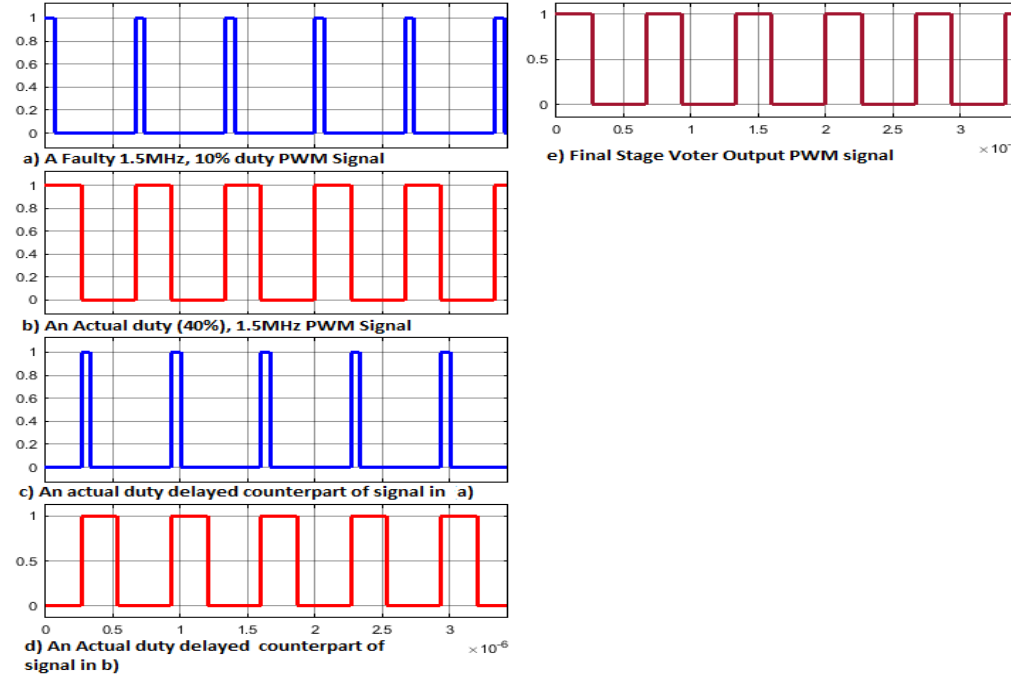
Figure 8. Third-stage detection and rejection process.